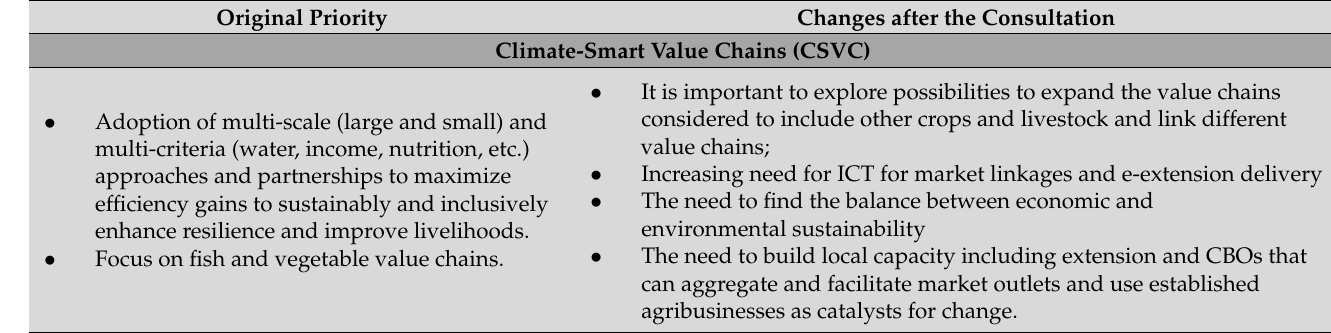
Table A2. Thematic areas, priorities, and knowledge/capacity gaps identified for each